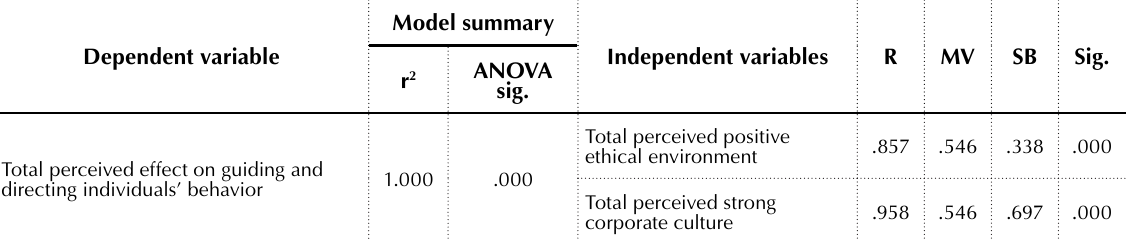
Table 2. Multiple regression results Dependent